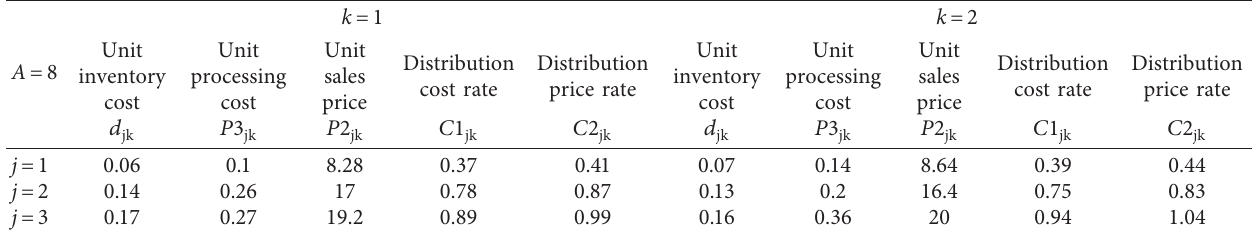
Table 2: Data table of distribution centers.